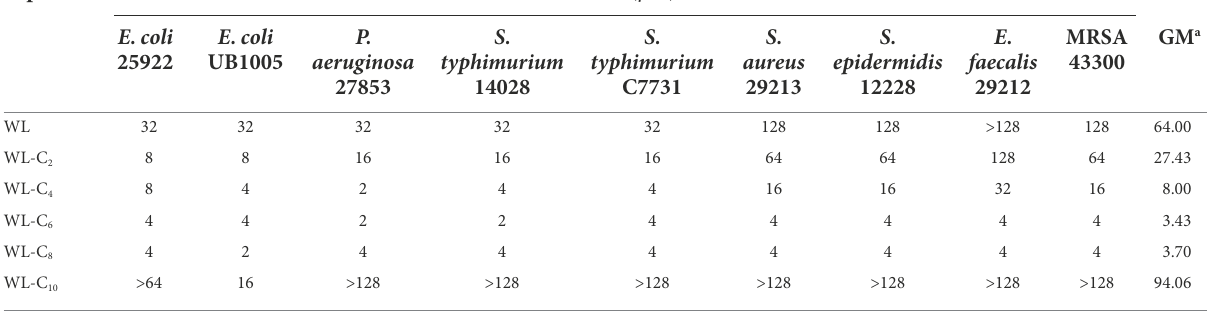
TABLE 1 Antibacterial activity of the peptides against a range of bacteria.